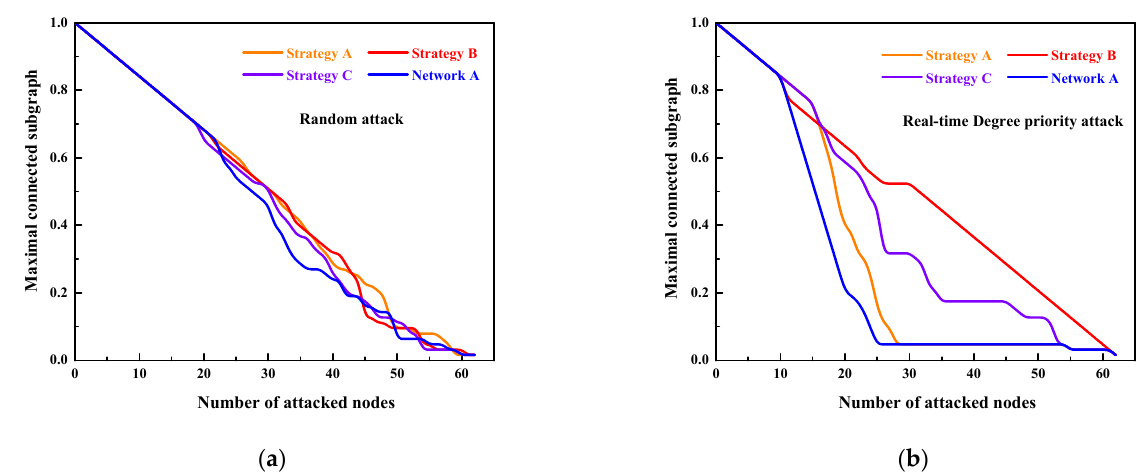
Figure 11. Graph of network potency factor under two attacks. ( a ) Random attack; ( b ) Deliberate attack.